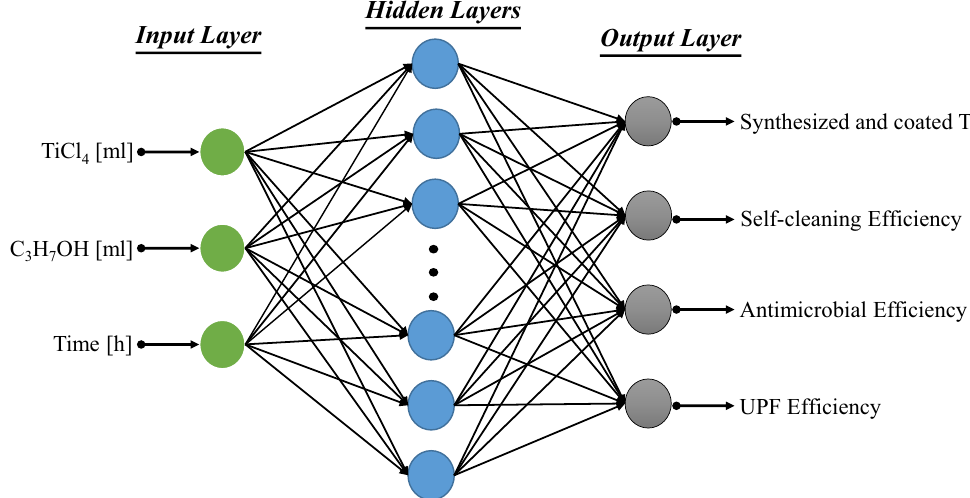
Figure 1. MLP model for the prediction of functional properties of nano TiO 2 coated